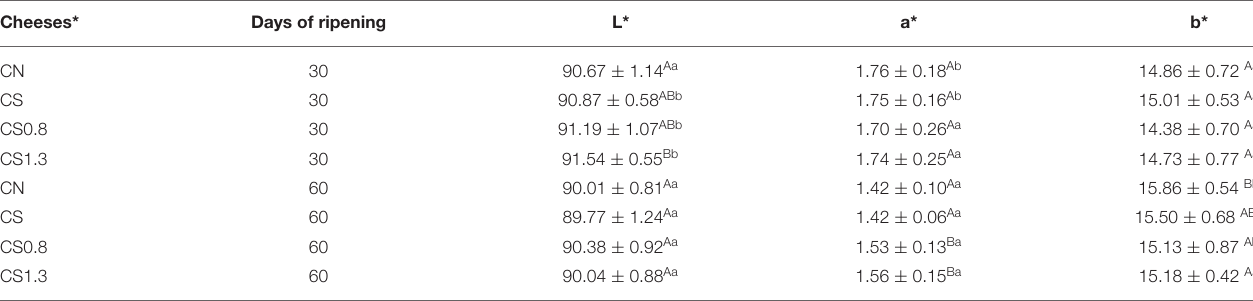
TABLE 8 | Color results of reduced-sodium cheeses by substituted-sodium treatment (CS) at 30 and 60 days of ripening. Cheeses* Days of ripening